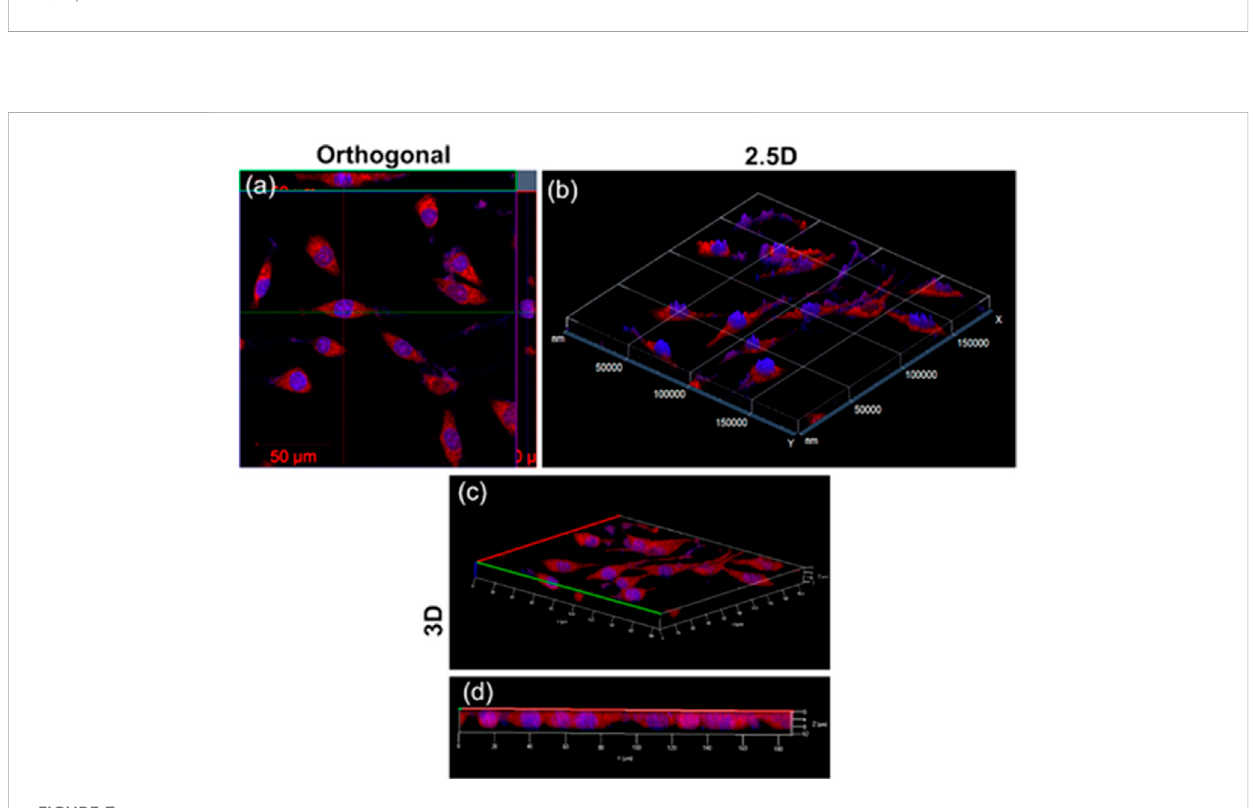
Frontiers in Cell and Developmental